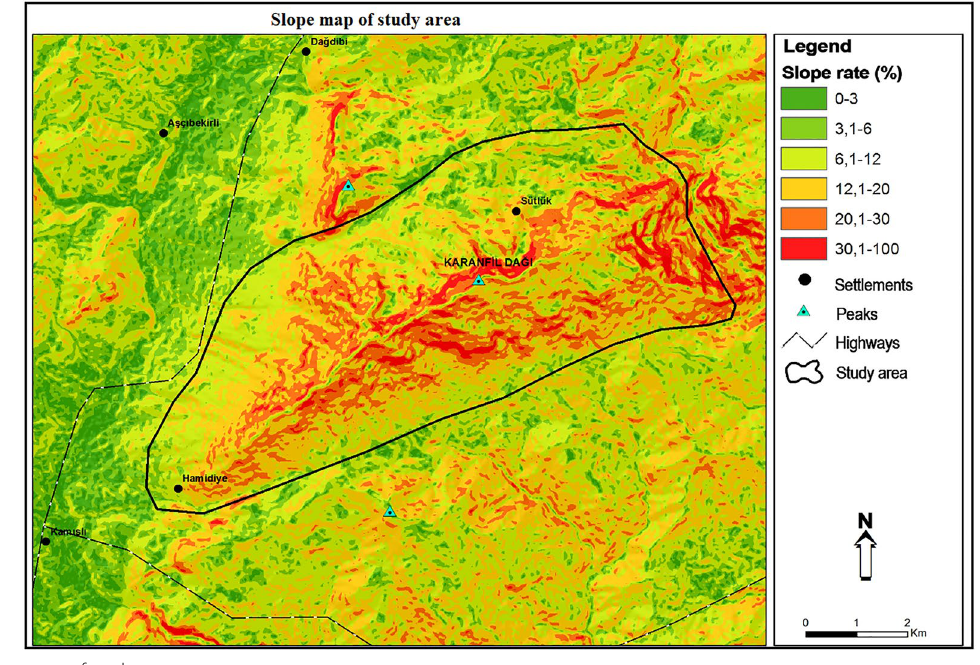
Fig. 13 Slope map of study area